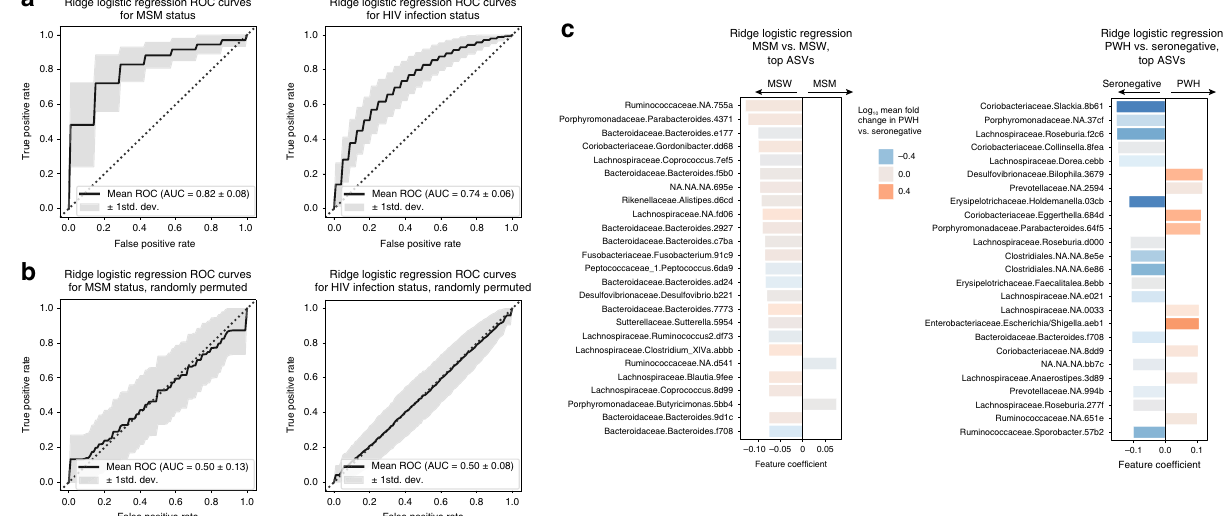
Fig. 5 Gut microbiota pro fi les robustly segregate samples by HIV infection status and sexual preference. a The ridge logistic regression application of machine learning was used to test robustness of differences between MSM vs. MSW ( n = 72 MSM, n = 22 MSW), and PWH vs. uninfected ( n = 71 PWH, n = 71 seronegative). Both MSM status and HIV infection status exhibited robust signatures by which ridge logistic regression could predict the classi fi cation status of unseen samples with high accuracy (AUROC = 0.84 for MSM vs. MSW with P = 0.015, AUROC = 0.73 for PWH vs. seronegative with P = 0.017). b Sample classi fi cations (e.g. MSM, MSW, PWH, seronegative) were randomly permuted to introduce noise into the dataset and quantify capacity for machine learning to classify persons based on spurious data. Random class label permutation demonstrated no classi fi cation accuracy to spurious data (AUROC = 0.5 for both MSM vs. MSW and PWH vs. uninfected). c Top ASV features that informed models for ridge logistic regression predictions of MSM vs. MSW and PWH vs. seronegative. Feature coef fi cients represent extent to which each ASV was weighted to represent the given class (positive for MSM vs. MSW indicated ASV was indicative of MSM; positive for PWH vs. seronegative was indicative of PWH). Bars are color-coded by log mean fold change in PWH vs. seronegative, and show a lack of correlation between ASVs informative for predicting MSM status and those altered in abundance in